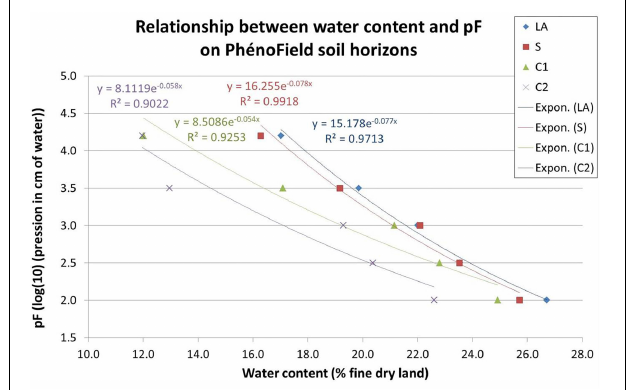
FIGURE 5 | Relationship between water content and pF on PhénoField soil horizons; LA: plowed horizon, S: cambic horizon, C1 et C2: calcaric material (C1: cryoturbed limestone; C2: sandy calcaric material).